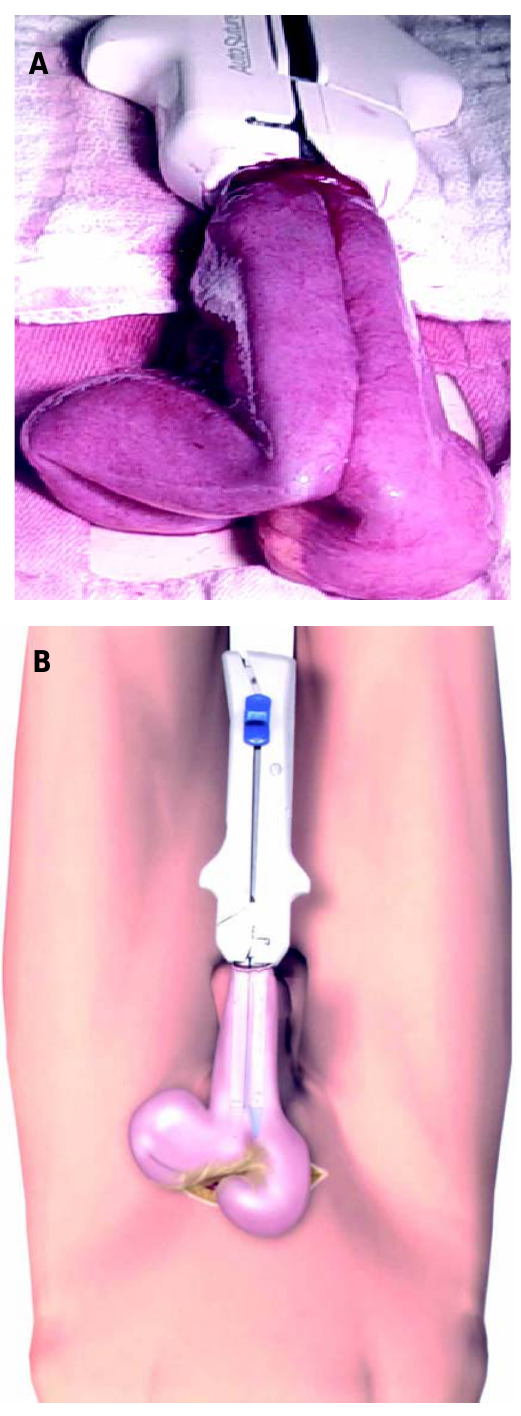
Figure 3 – A) Photograph showing the Y-shaped neobladder being created with non-absorbable titanium staples; B) Sche- matic